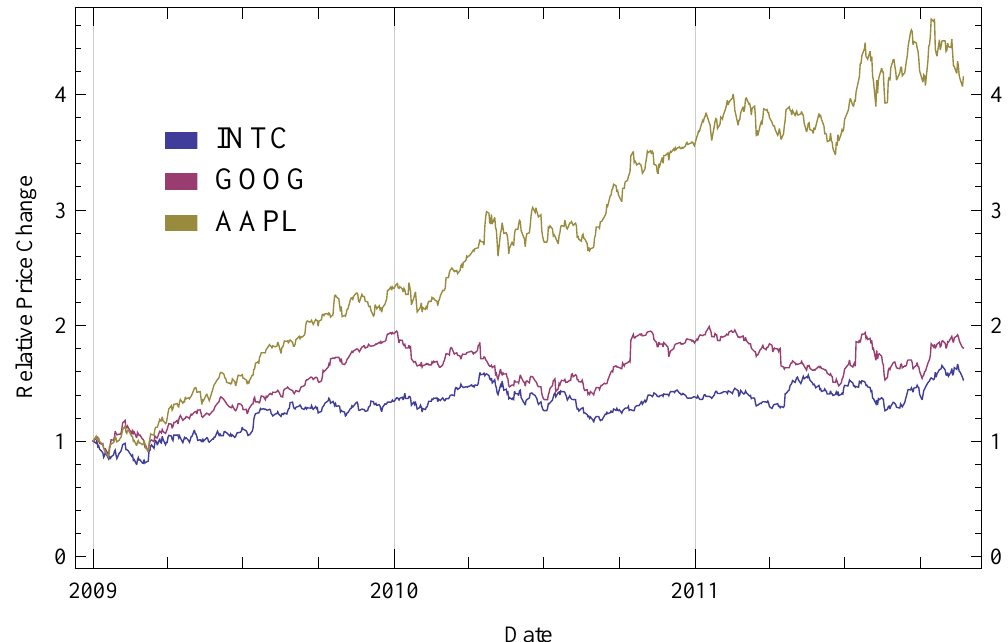
Figure 10. Relative price change of three stock tickers over the time period considered, normalized to start from the same relative value.